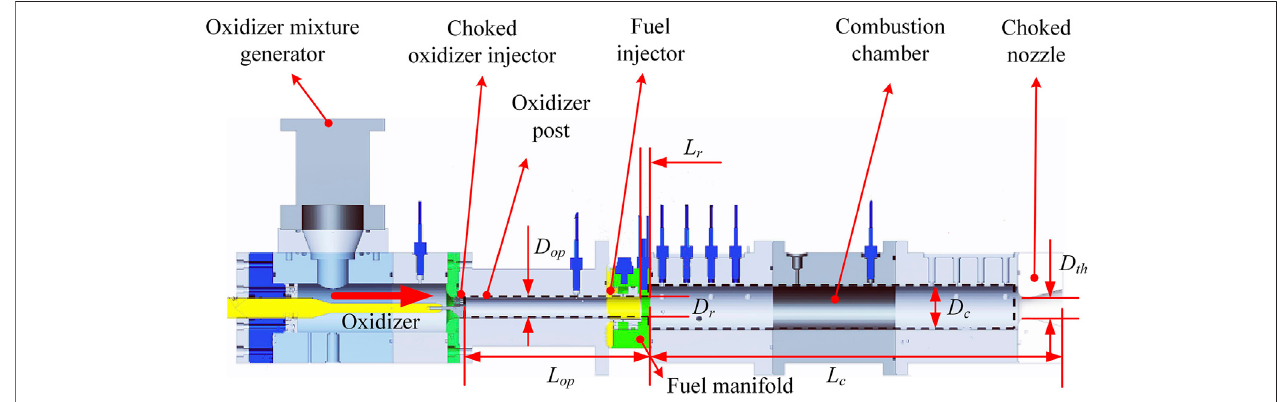
FIGURE 1 | Schematic of the single-element combustor (reproduced from (Yu et al., 2009))